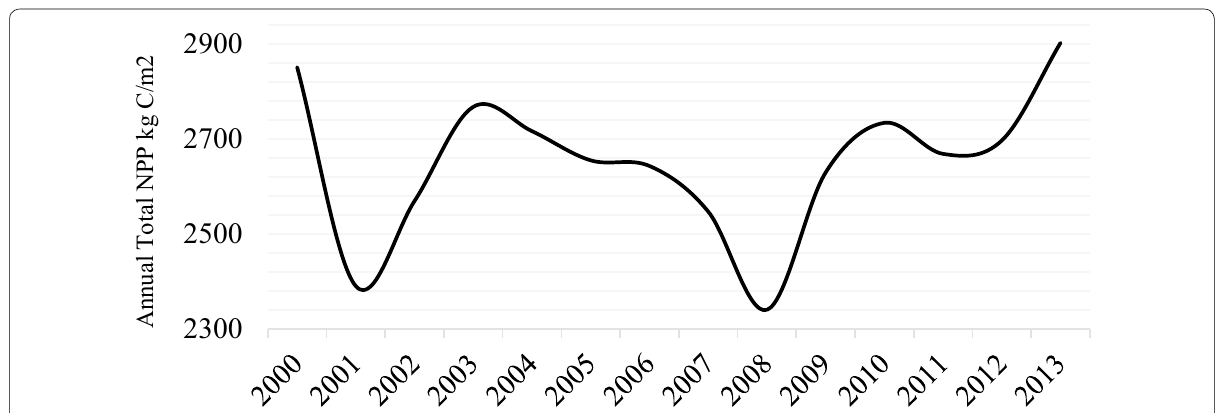
Fig. 5 Temporal changes in vegetation productivity (NPP) in Guna-Tana